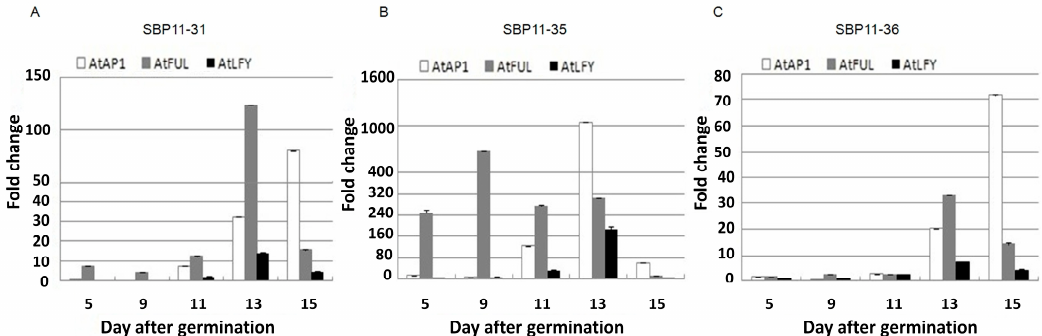
Figure 4. The meristem identity switch genes ( AtAP1 , AtFUL , and AtLFY ) expression in VpSBP11 transgenic lines. ( A ) SBP11-31; ( B ) SBP11-35 and ( C ) SBP11-36 compared to wild-type plants. AtActin1 was used as an internal control for qRT-PCR and fold changes were used to indicate expression levels in leaves compared to WT controls. Mean values and SDs were obtained from three biological experiments with consistent results.